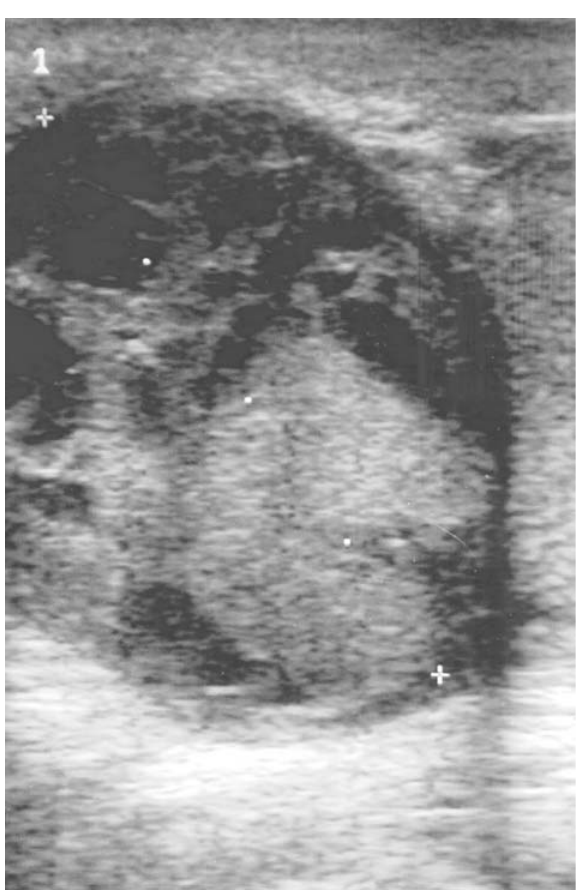
Figure 1 – Ultrasonography showing a well-defined extra tes- ticular mass with cystic and solid